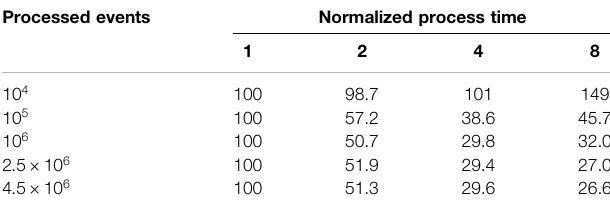
TABLE 4 | Runtimes as percentages of single core runtime.